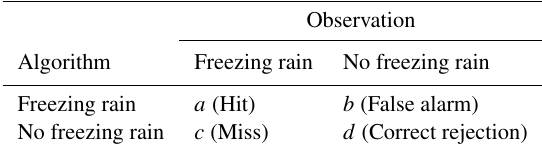
Table A1. Contingency table of the comparison between observa- tions and the algorithm. The symbols a – d represent the different number of FZRA events observed to occur in each